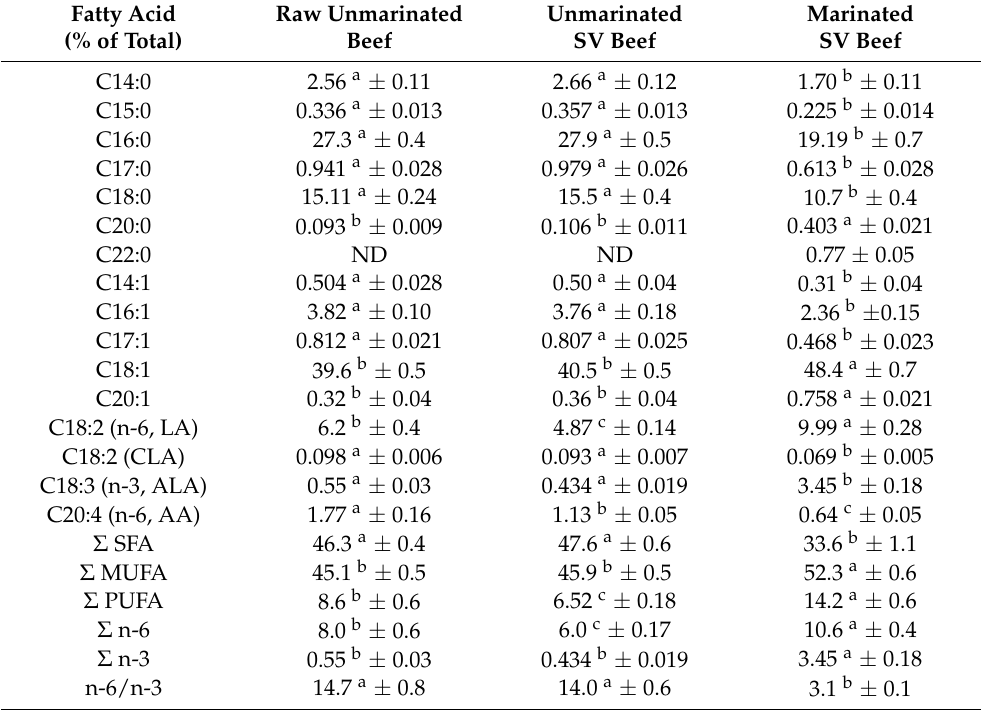
a,b,c —values in rows with different lower case letters differ significantly at p < 0.05; ND—not detected; Σ SFA the sum of the proportion of C14:0, C15:0, C16:0, C17:0, C18:0, C20:0, C22:0; Σ MUFA the sum of the